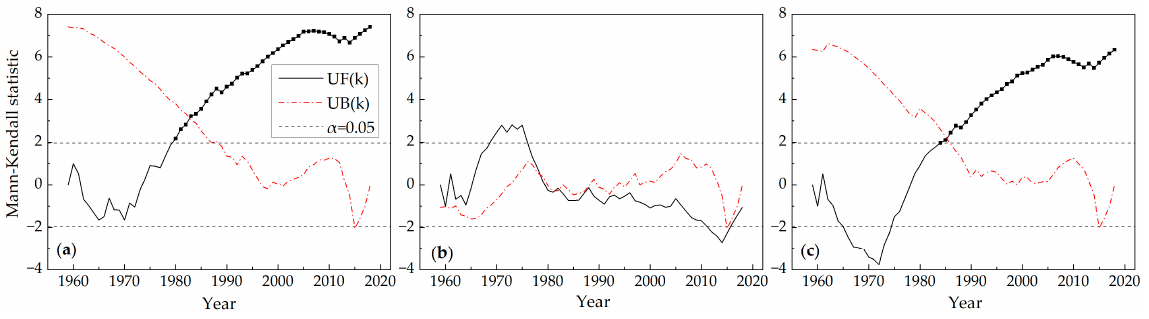
Figure 8. The Mann–Kendall statistic curves during the period of 1959–2018: ( a ) the annual UHII mean ; ( b ) the annual UHII max ; ( c ) the annual UHII min .